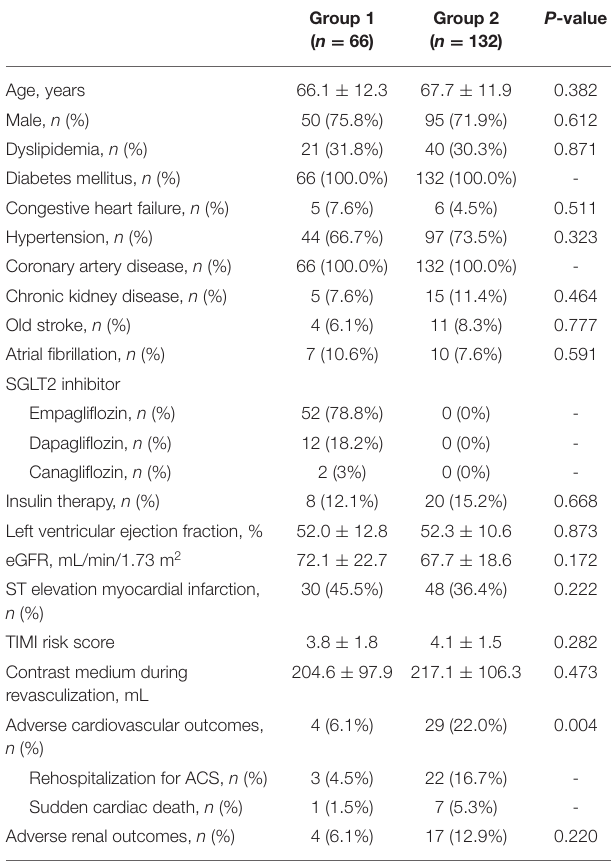
TABLE 1 | Baseline characteristics of the study